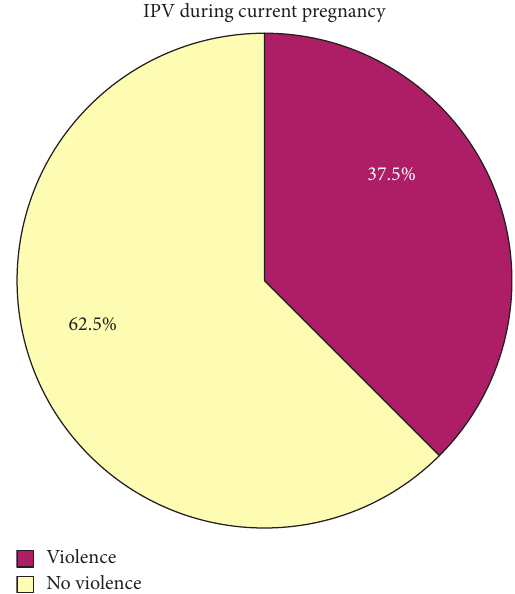
Figure 1: Magnitude of intimate partner violence among pregnant women attending antenatal care services at public health facilities in Ofla District, Tigray, Ethiopia, 2019 ( N � 538).